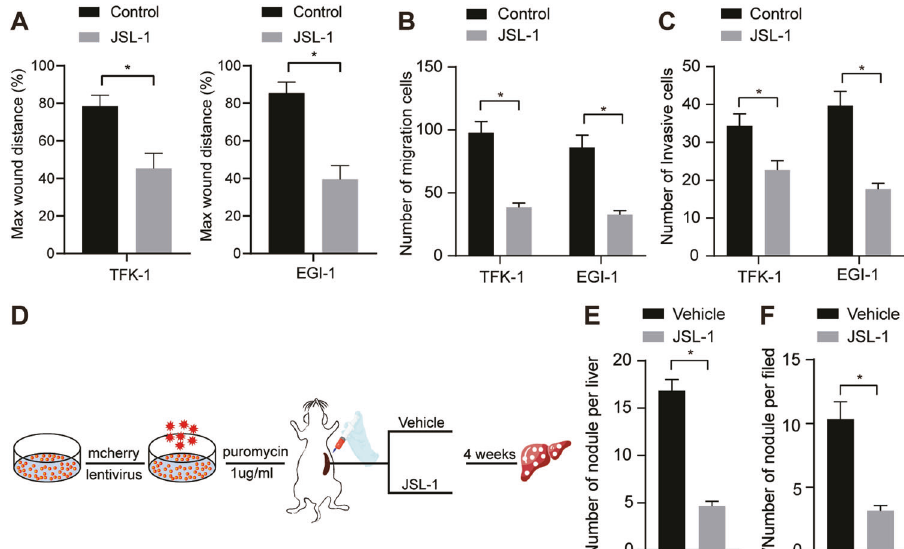
Fig. 8 JSL-1 curbs the migratory, invasive and metastatic abilities of CC cells in vitro and in vivo. A Wound healing ability of cells treated with JSL-1 assayed by scratch test. B Cell migration upon JSL-1 treatment assessed by Transwell assay. C Cell invasion upon JSL-1 treatment assessed by Transwell assay. D Program fl owchart of tumor metastasis model developed in nude mice and JSL-1 treatment. E The number of nodules in the mouse liver surface after JSL-1 treatment. F Analysis for HE staining of the nodules inside the mouse liver and quantitative analysis after JSL-1 treatment. * p < 0.05. In panels ( A – C ) and ( E , F ), data were compared by unpaired t -test. The cell experiment was independently repeated three times. n = 6 for animal experiment.